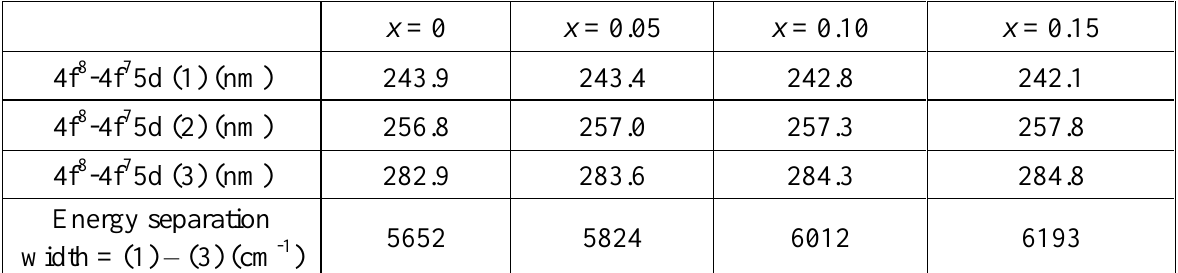
Gd )OBr:5%Tb 3+ ( x = 0 – 1- x x